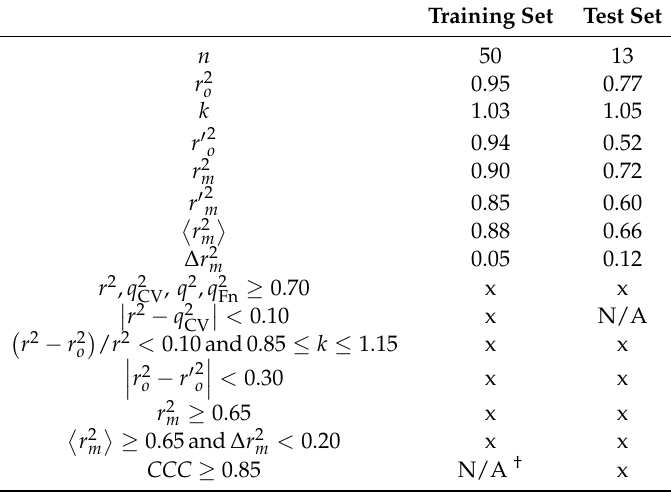
Table 4. Validation verification of HSVR based on prediction performance of those molecules in the training set and test set. Training Set Test Set n